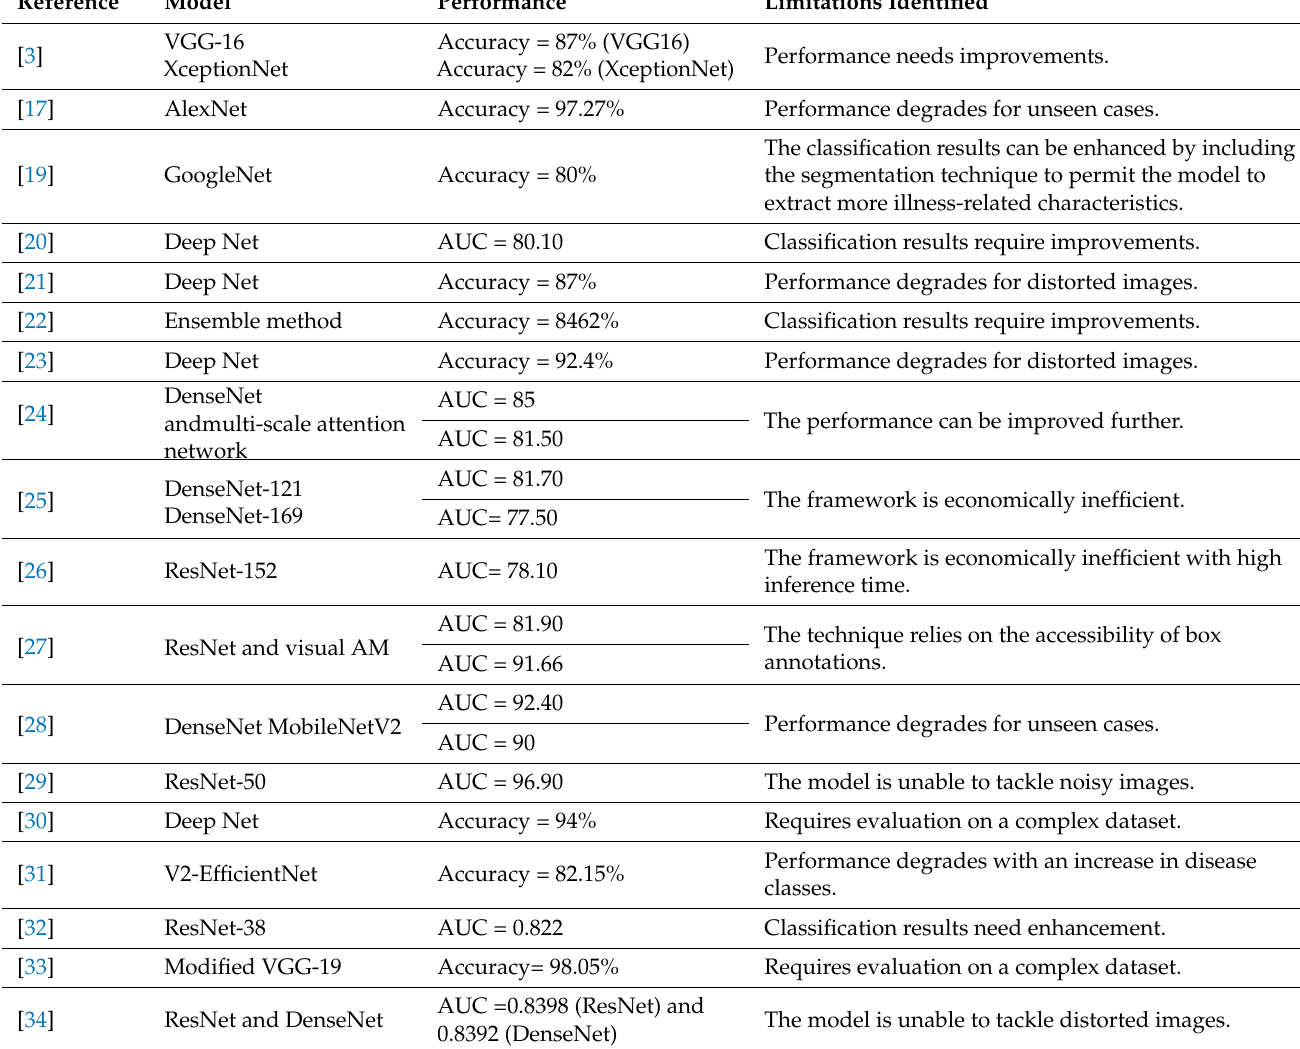
Table 1. An evaluation of the existing